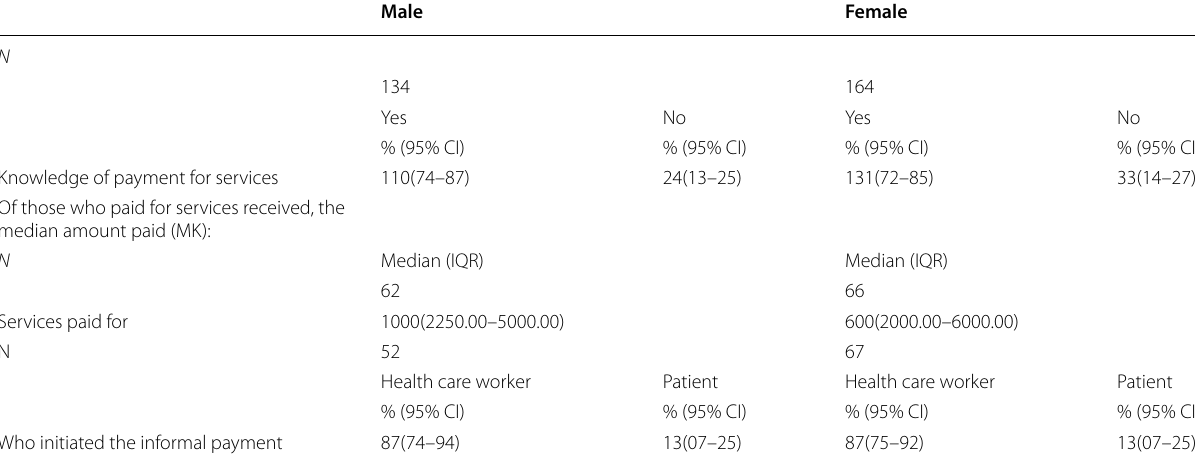
Table 4 Payments for health services reported by patients exiting the health facility